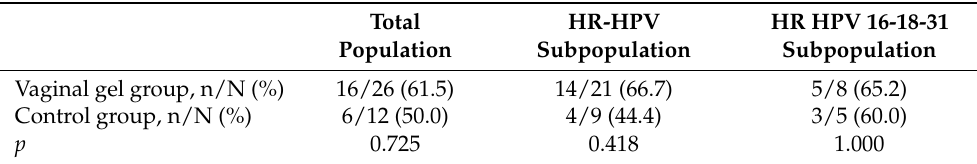
Table 2. HPV clearance (sum of total and partial) at follow-up visit at 6 months.